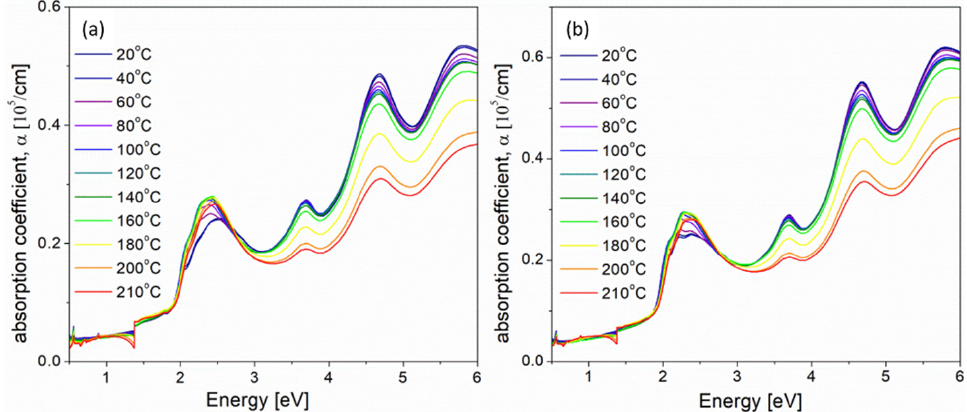
Figure 6. Absorption coefficient spectra, measured at different temperatures, within the whole UV-Vis-NIR spectral range, of iodine-doped P3HT:PCBM (1:1) blend thin films with ( a ) 5% and ( b ) 10% mol. concentration.